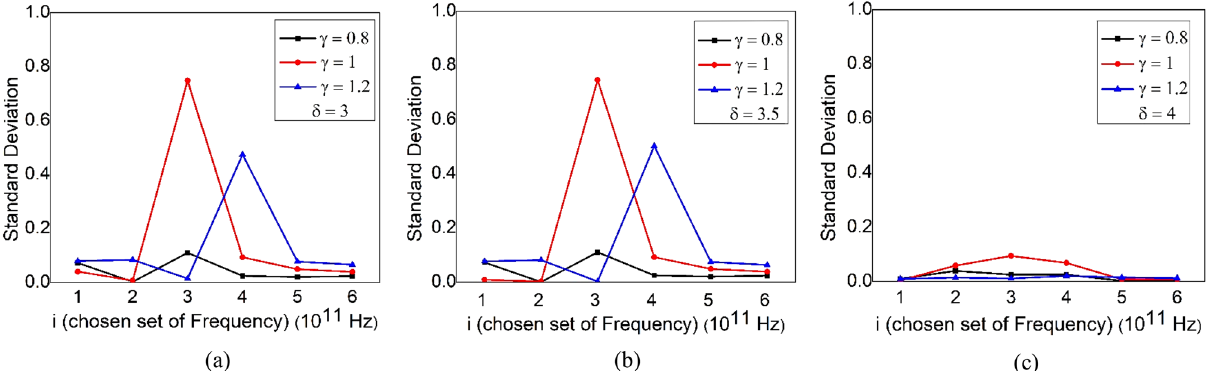
Figure 2. The standard deviation is plotted against the chosen set of frequencies. We have used different profiles of b(T) by varying δ and γ in Eq. (10). For ( a ) δ = 3, ( b ) δ = 3.5 and ( c ) δ = 4. For different γ values, the standard deviation differs slightly.